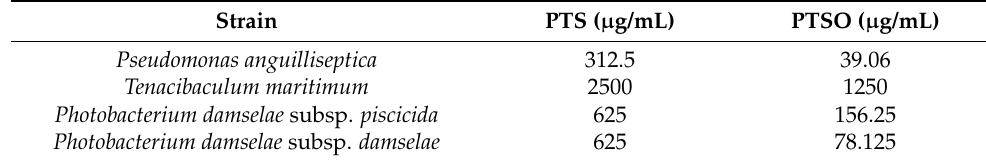
Table 2. Minimum Bactericidal Concentration (MBC) of PTS and PTSO against target bacteria.